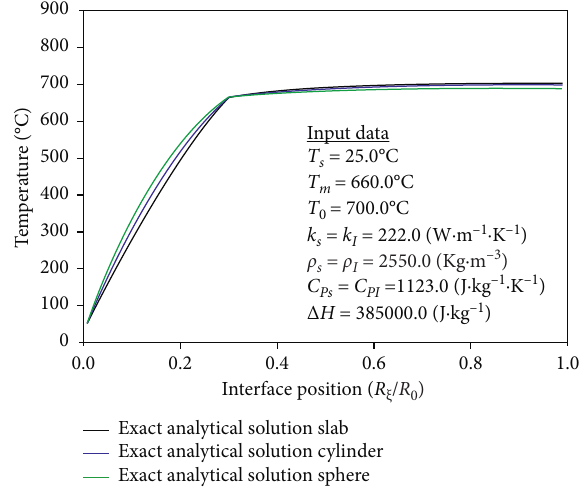
Figure 20: Comparison of concentration profiles during inward diffusion of a slab, a cylinder and a sphere as a function of di- mensionless position ( R